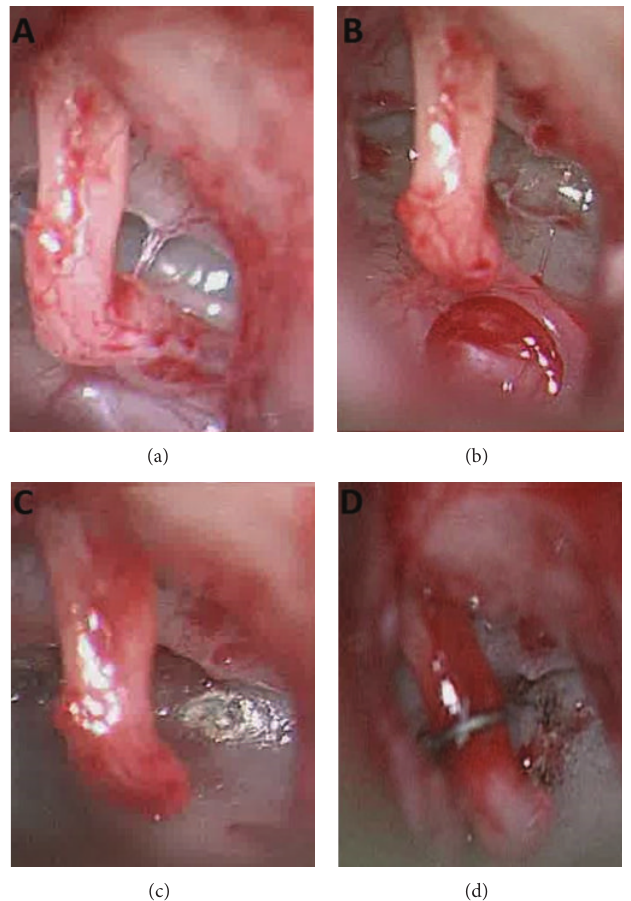
Figure 1: Intraoperative microscopic view of middle ear (a). Following tympanotomy, note lack of connection between stapes superstructure and footplate alongside absence of stapedius tendon (b). Following dislocation of incudostapedial joint (c). Following laser stapedotomy (d). Following placement of prosthesis and crimping by KTP laser.